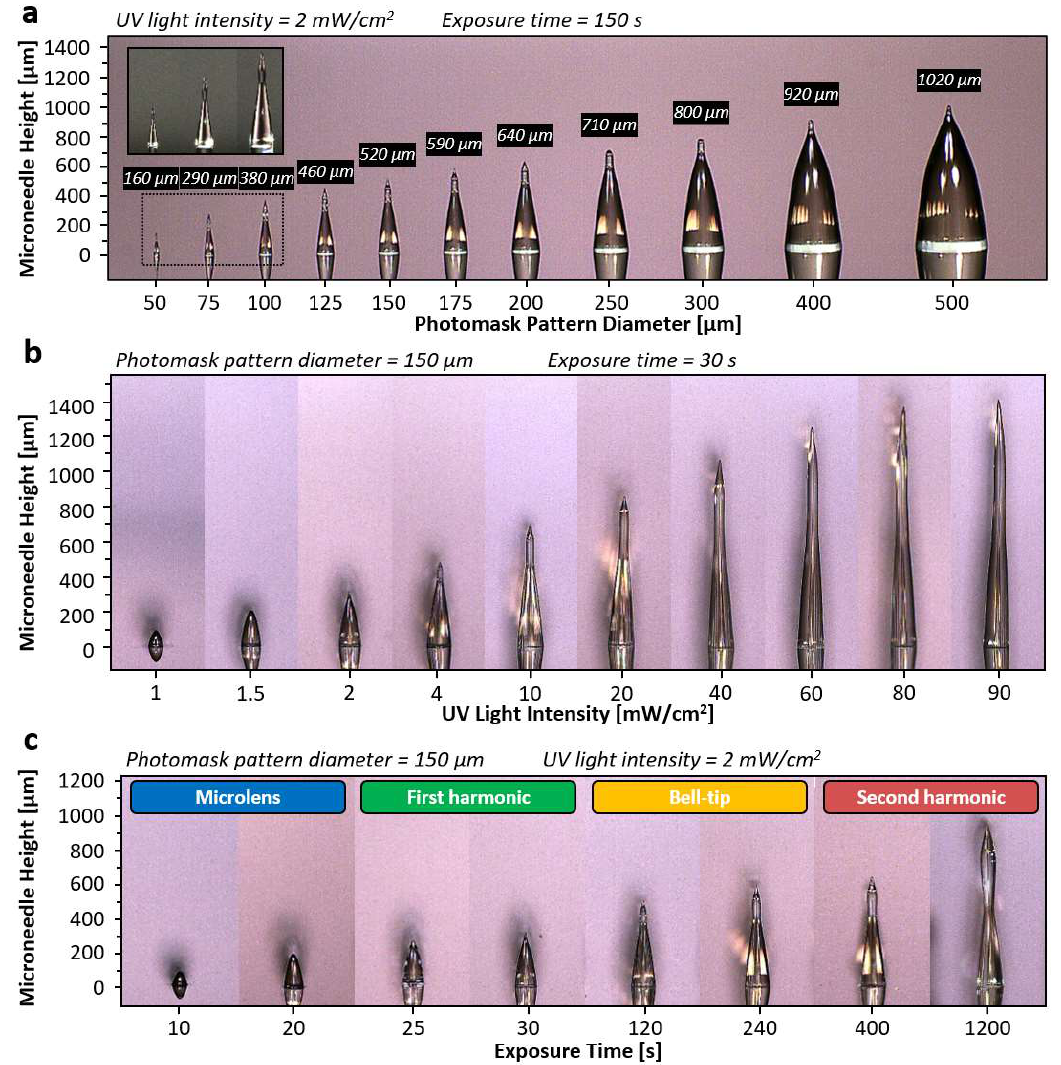
Figure 4. Microneedle characterization results based on the three parameters. ( a ) Photopattern diameter as the variable (50, 75, 100, 125, 150, 175, 200, 250, 300, 400, and 500 µm), microneedles height increases as diameter increases while microneedle phase progresses slower as diameter increases. Inset image show the enlarged view of the microneedles with diameter of 50, 75 and 100 µm. ( b ) UV light intensity as the variable (1, 1.5, 2, 4, 10, 20, 40, 60, 80, and 90 mW/cm 2 ), microneedle forms higher tip to body or height to base ratio as the intensity increases given the same microneedle phase. ( c ) Exposure time as the variable (10, 20, 25, 30, 120, 240, 400, and 1200 s), microneedle progresses through microlens, first harmonic, bell-tip and second harmonic phases with increasing height as the exposure time